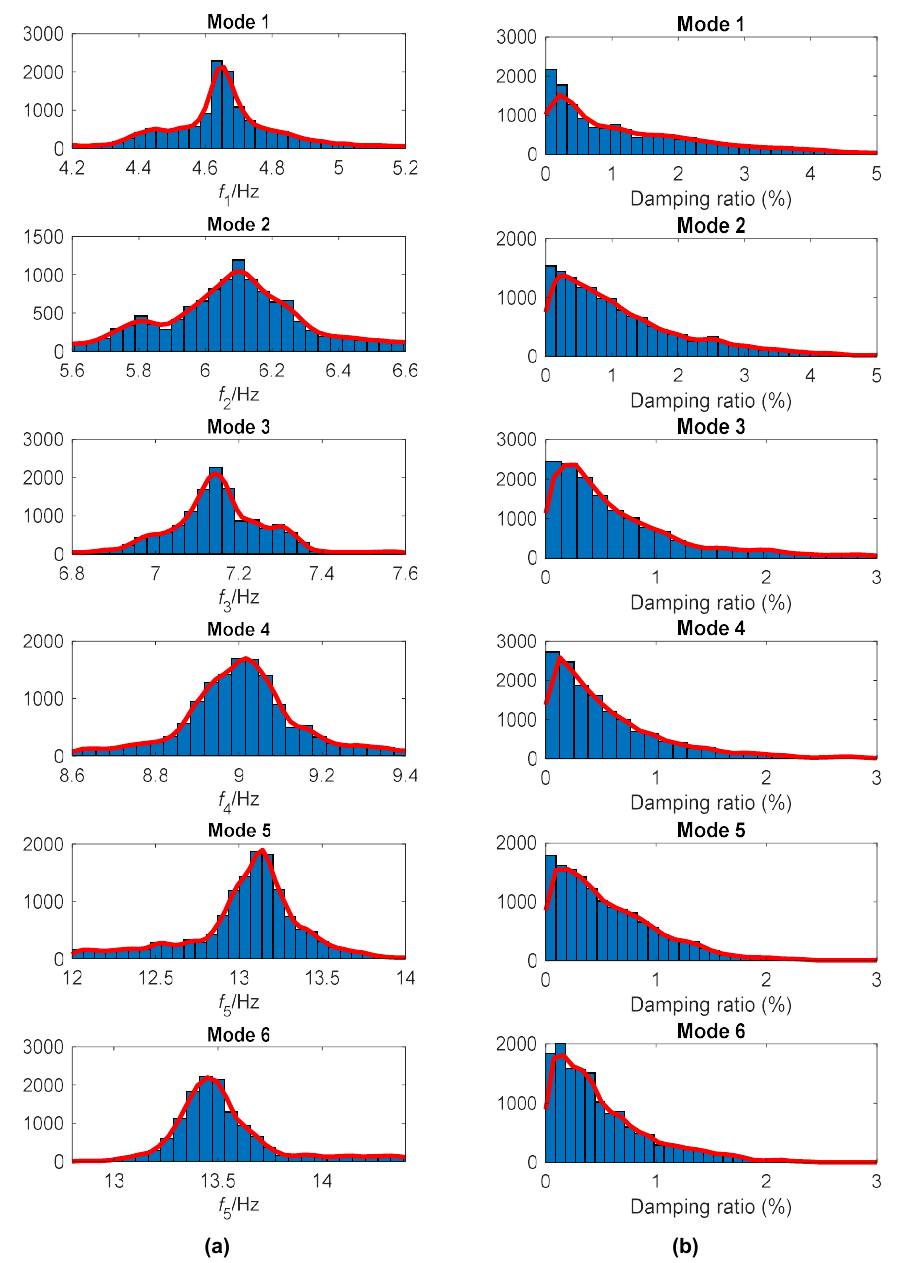
Figure 18. Histograms for the instantaneous modal parameters of DHF identified by EWT: ( a ) Instantaneous frequency; ( b ) damping ratio.